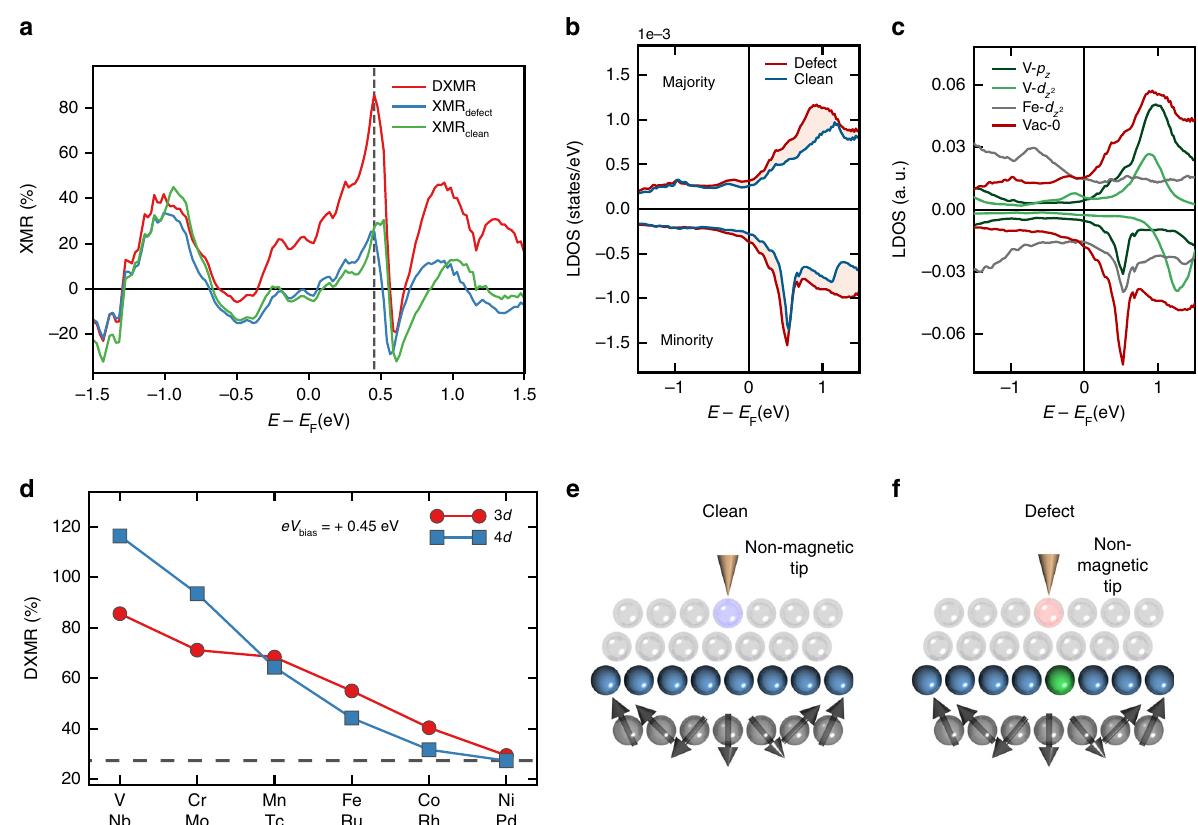
Fig. 2 Ef fi ciency of the XMR signal and the electronic structure. a Comparison of various energy-resolved XMR signals measured on top of the skyrmion's core with V impurity located close to skyrmion's core. The dashed line indicates the energy at which the DXMR reaches the maximum ef fi ciency. b Electronic structure in the vacuum on top of the skyrmion's core resolved into majority and minority spin-channels for the clean system (blue line) and with a V-impurity (red line). c Superposition of the electronic states in vacuum of V and Fe at the skyrmion's core. Note that arbitrary units are used to include all of the curves in the same plot. d Impact of chemical nature of the defect on the DXMR signal at an injection energy eV bias = 0.45eV for 3 d (red circles) and 4 d (blue squares) impurities located close to the skyrmion center. The gray dashed line indicates the signal of the XMR clean . e , f Illustrative legend for the STM-tip probing the clean (defective) substrate at the location de fi ned by the light blue (red) sphere, whose color corresponds to the LDOS plotted in ( b ). Vacuum is simulated by empty cells, schematically represented as